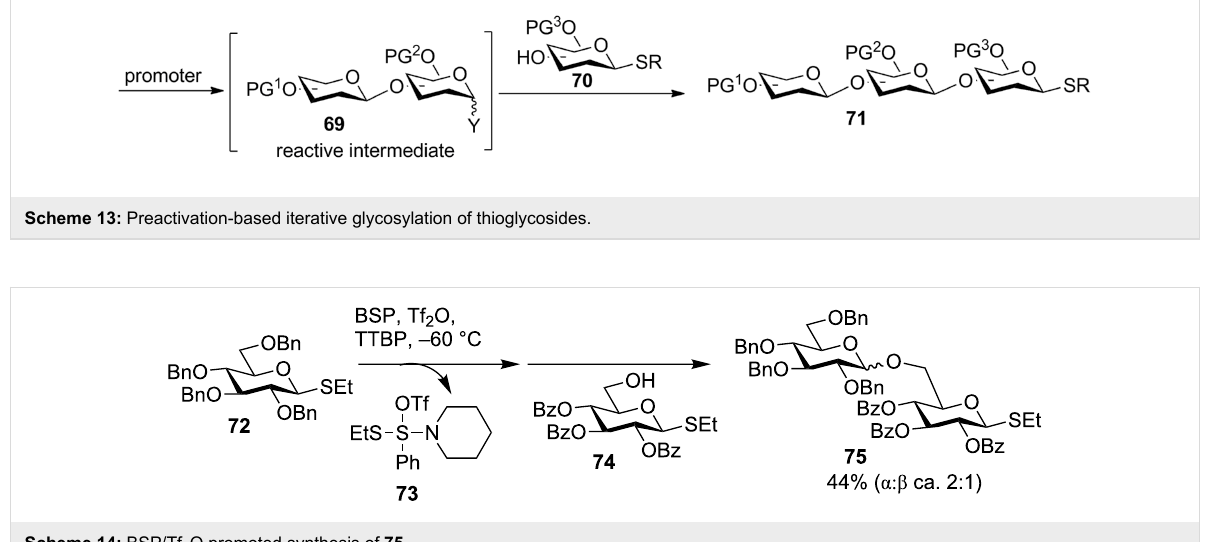
Scheme 14: BSP/Tf 2 O promoted synthesis of 75